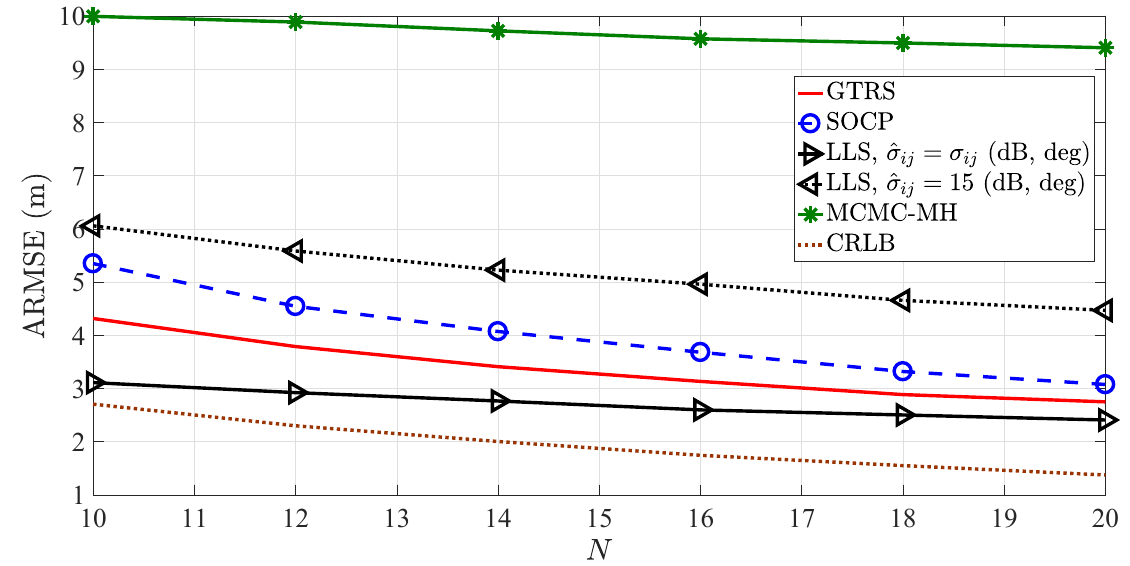
Figure 12. Average root mean square error (ARMSE) (m) versus N : M = 50, R = 10 m, M c = 1000. CRLB = Cramér-Rao lower bound (CRLB).